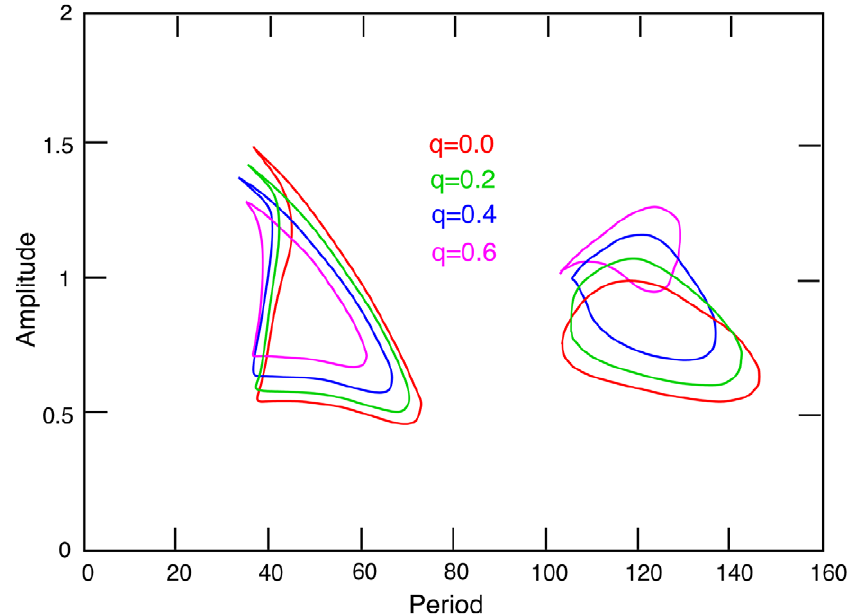
Figure 9. The effects of feed-forward inhibition on pattern formation. Stability boundaries for the homogeneous solution as amplitude and period vary, but the inhibitory population receives input of strength qA where A is the amplitude.